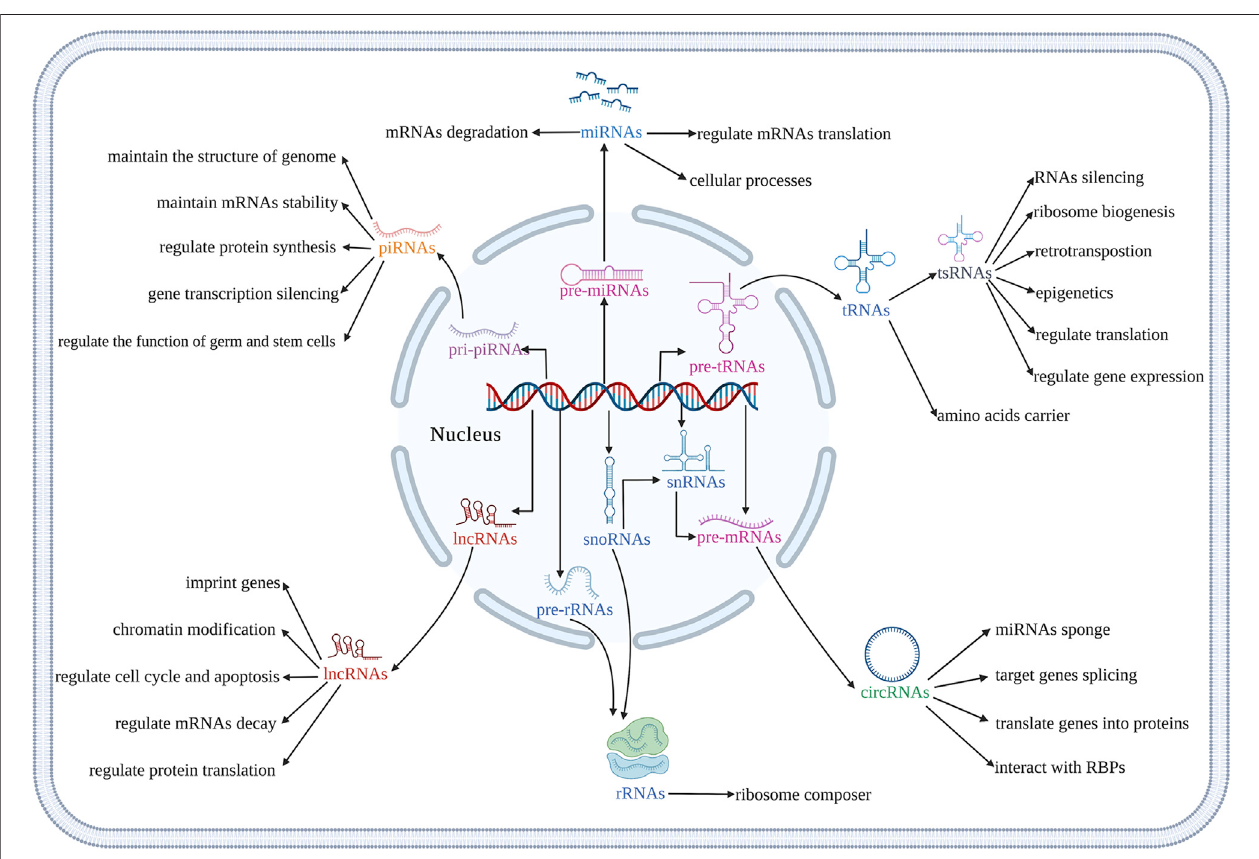
FIGURE 1 | Illustration of biological functions of different kinds of ncRNAs. (Created with BioRender.com).